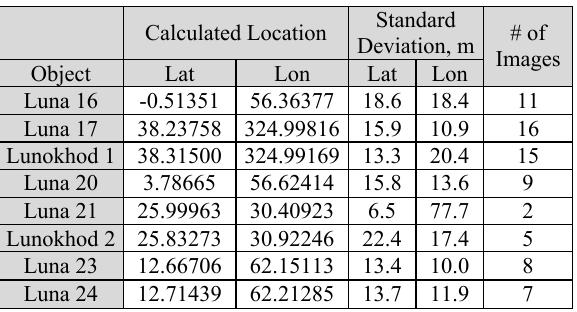
Table 2. Location of Soviet hardware derived from